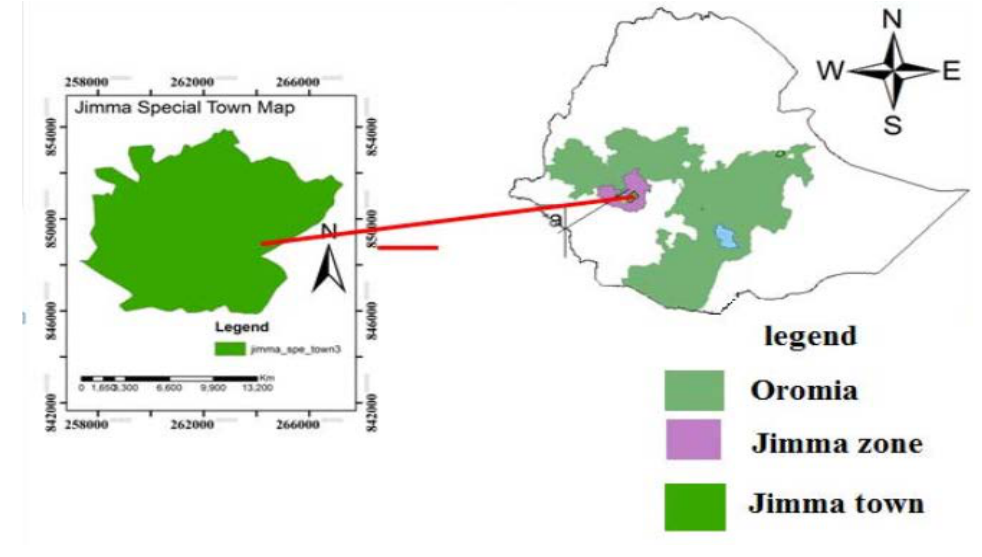
Figure 1. Map of the study